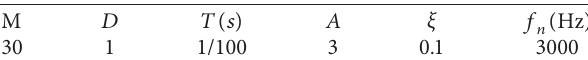
Table 1: Parameters of the outer race fault model.